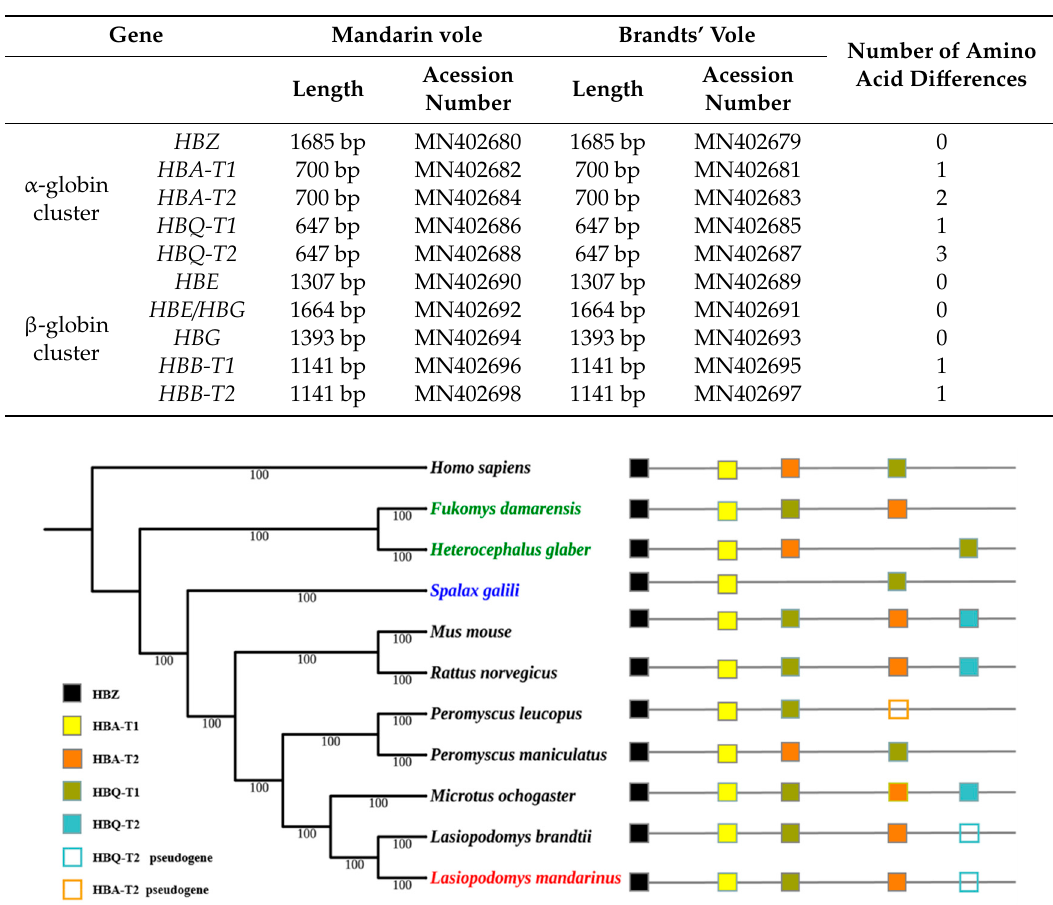
Figure 2. Bayesian tree of rodent species and the genomic structures of their α -globin genes. Numerals indicate Bayesian posterior probability values; colored text indicates subterranean rodent species.